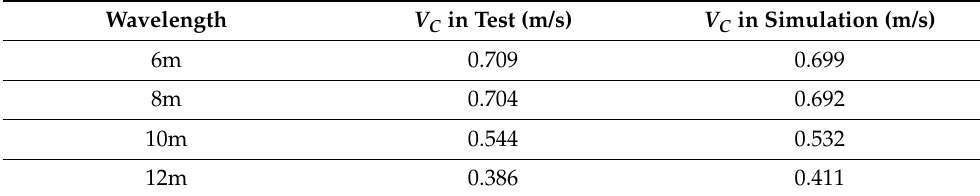
Table 13. Average values of V C in test and simulation (Wave height is 0.25